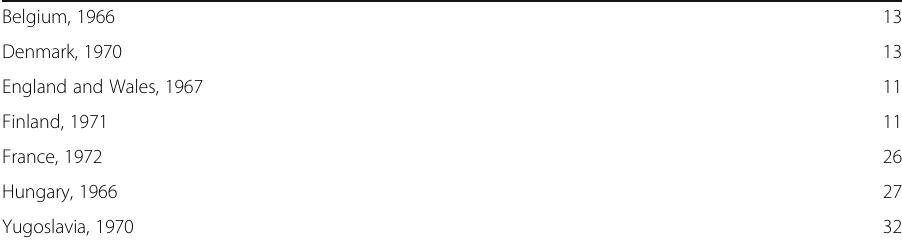
Table 3 Percent of fecund nonpregnant women who do not want more children and do not use